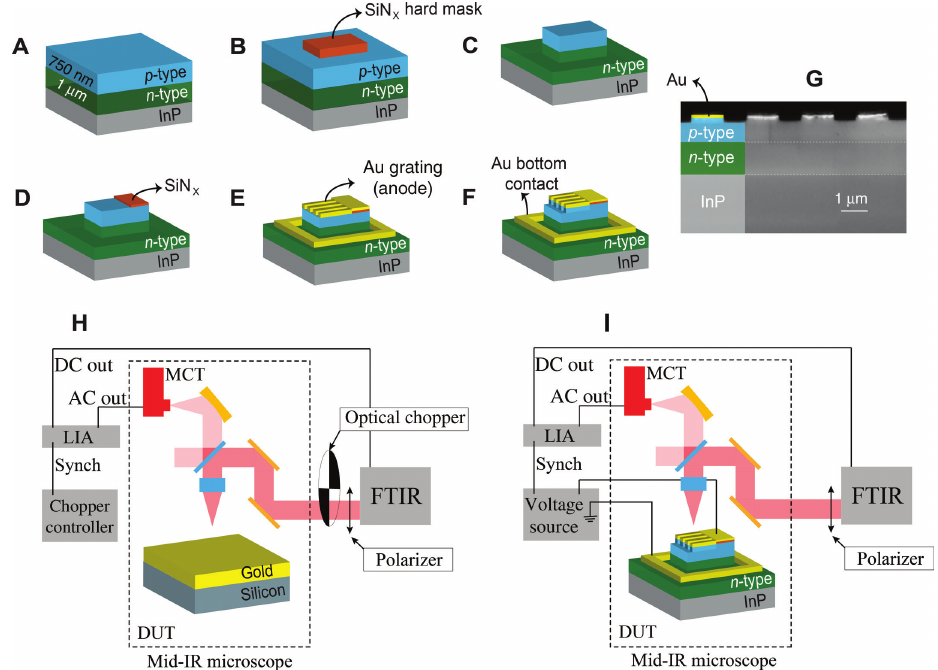
Figure 2: SPPD fabrication, sample SEM image, and experimental setup. (A) Layer structure of the In Ga As pn ++ diode grown on InP. (B) Device layout after first SiN 0.53 0.47 (C) ICP dry-etching to form a mesa pattern on the p-doped layer, followed by BOE etching to remove SiN electrical isolation layer. (E) Bottom and top metal contact deposition. (F) ICP dry-etching of grating. (G) Cross-sectional SEM image of the device. Experimental setups for (H) obtaining the reference gold surface reflection and (I) polarization-dependent reflection change under external applied